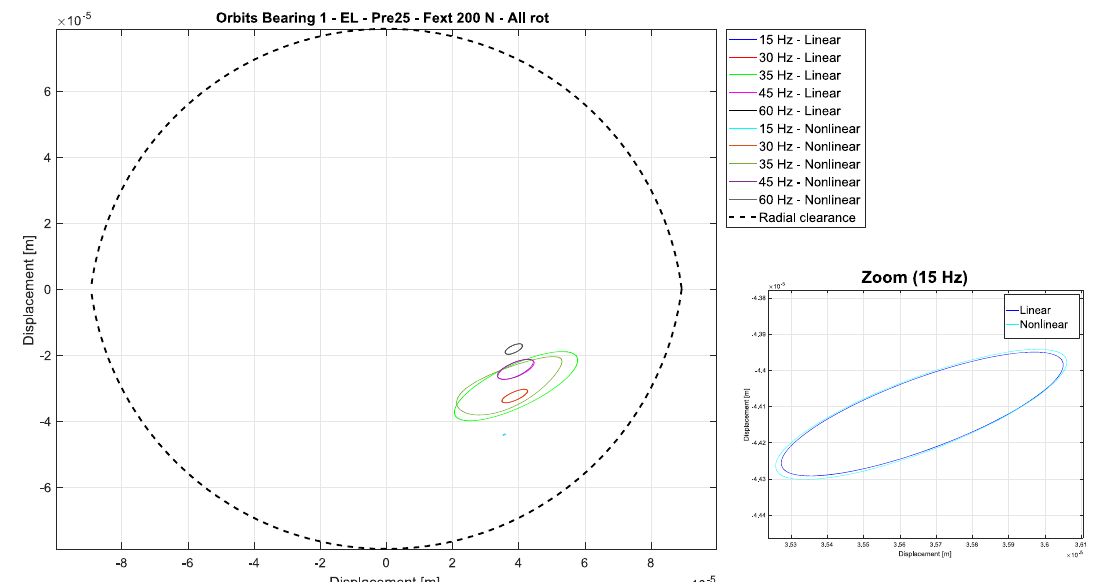
Figure 5. Orbits for all rotations simulated in elliptical bearing 1 (preload 0.25), with zoom in rotation 15 Hz.